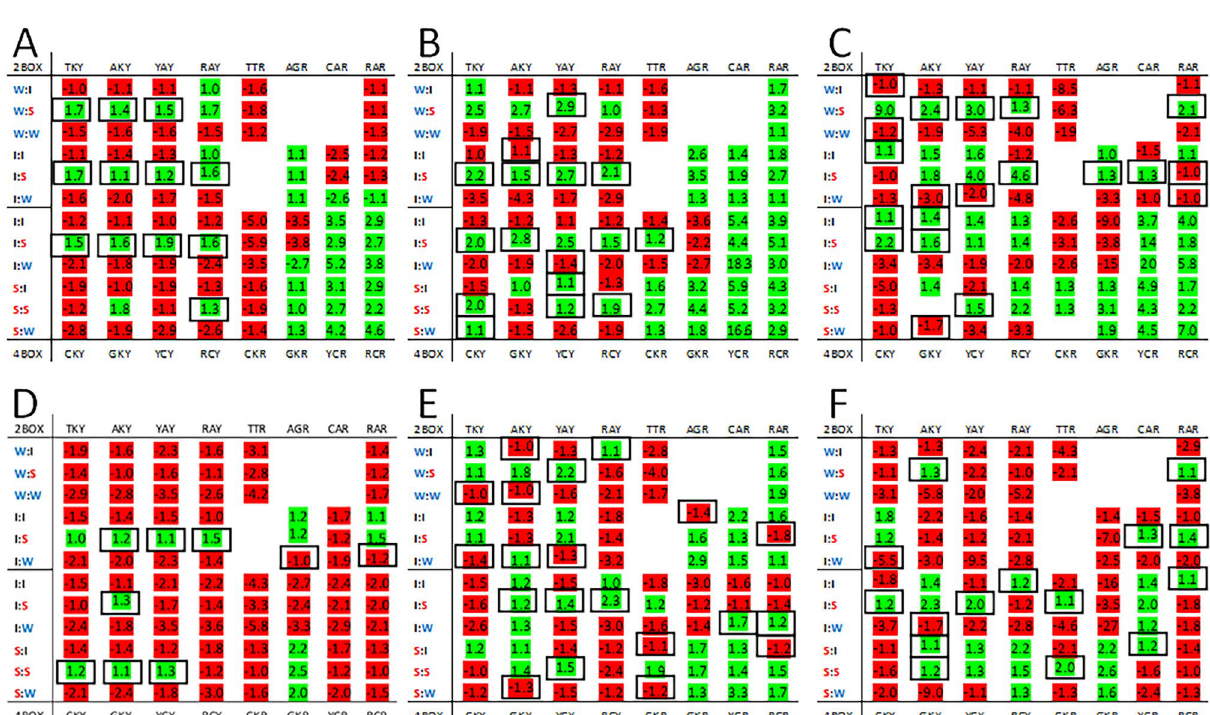
Figure 6. Heatmaps for Homo sapiens (human) ( A ), Flaviviridae ( B ), and Culicidae (mosquito) ( C ). Features of the heatmaps are described in the “Methods” section. Black boxes indicate cells with biases opposite of the expected and with a frequency greater than 1.05 for either observed or expected ratio.